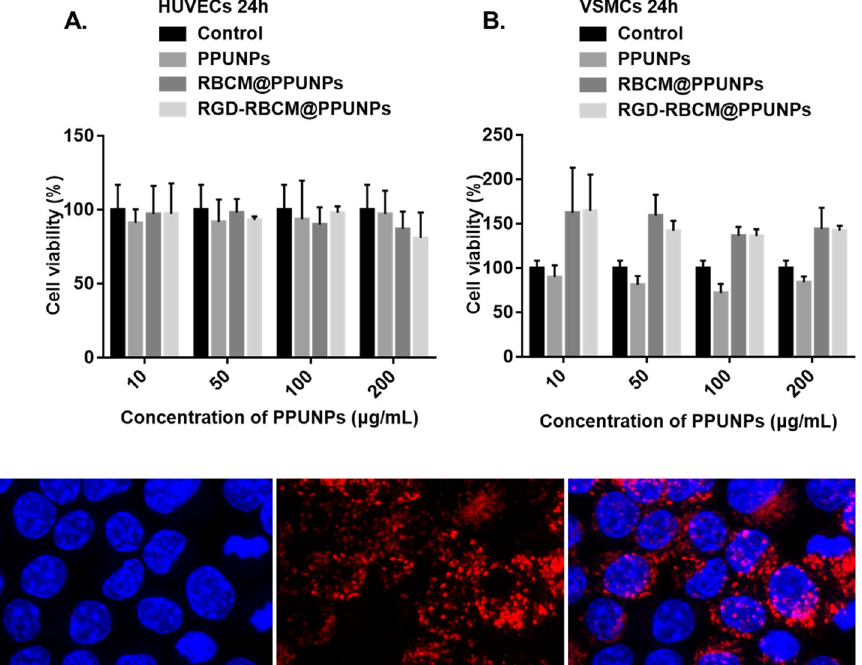
Fig. 8 Confocal laser scanning microscope images of macrophages incubated with DiDNPs, RBCM@DiDNPs and RGD-RBCM@DiDNPs for 4 h. DAPI-stained nuclei (blue), NPs (red). (Scale bar: 5 μ